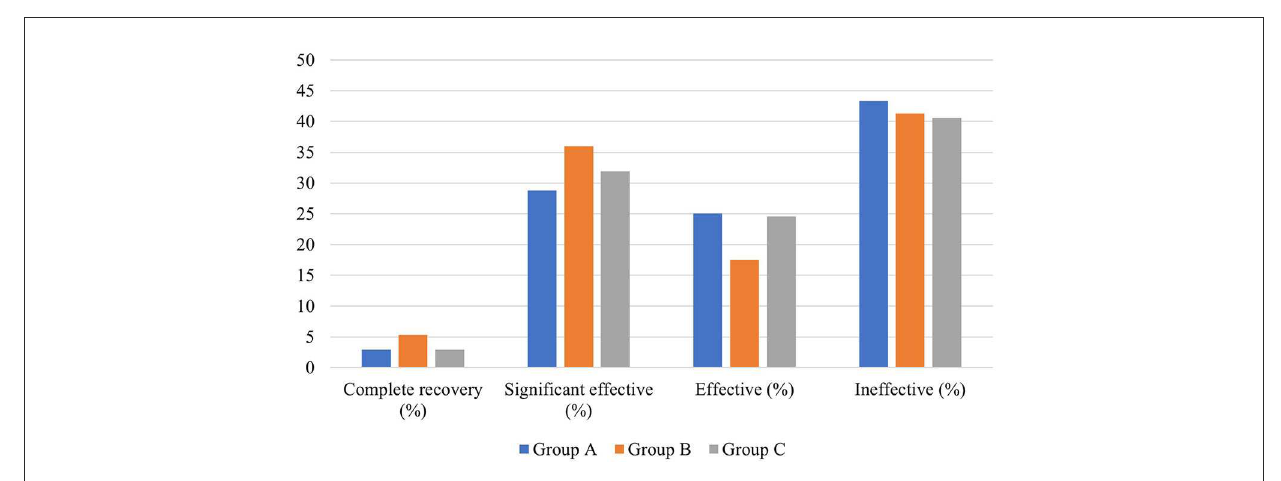
FIGURE8 Hearing efficacy of patients with profound SSNHL in the three